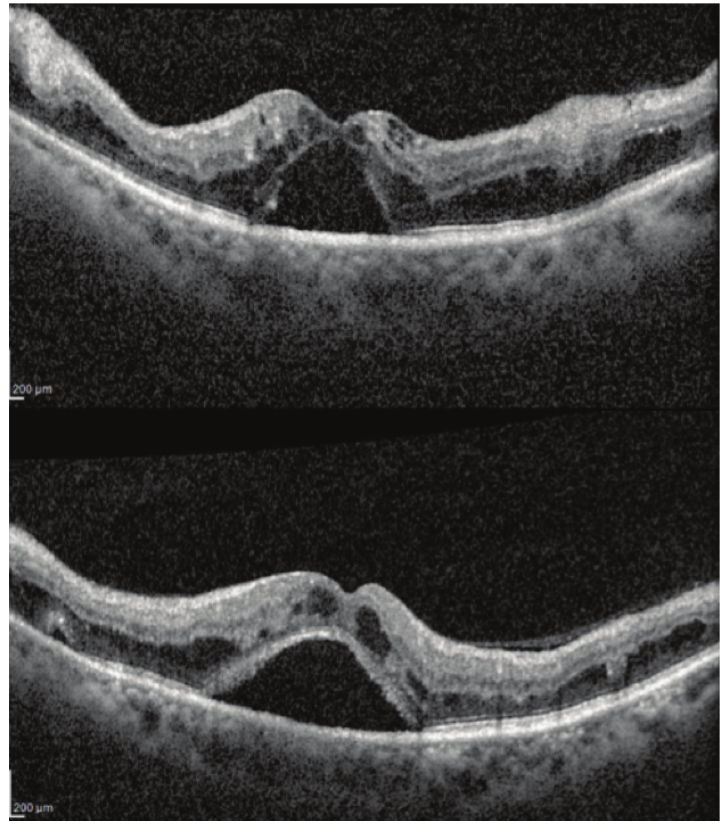
Figure 2. Optical coherence tomography of the right (above) and left (below) eyes at presentation showing cystoid macular edema and serous macular detachment.